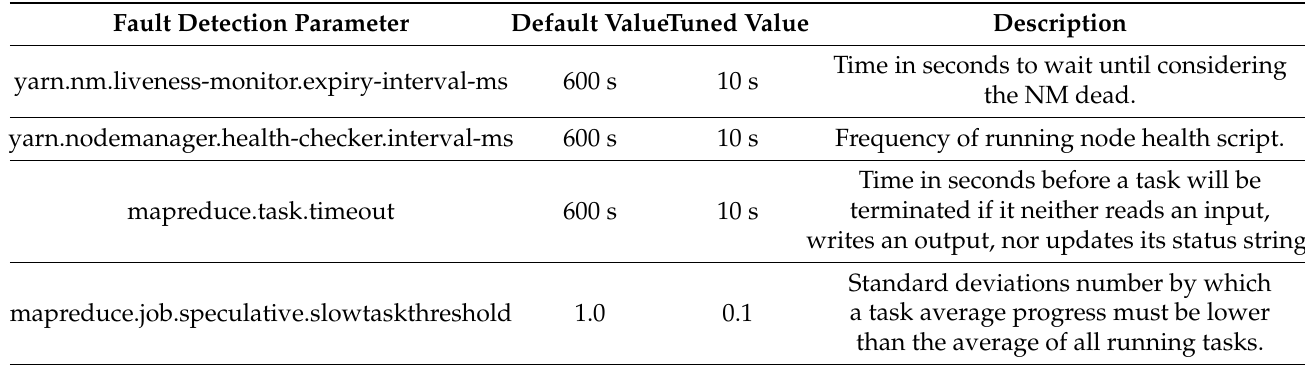
Table 3. Configurable fault detection parameters provided by Hadoop